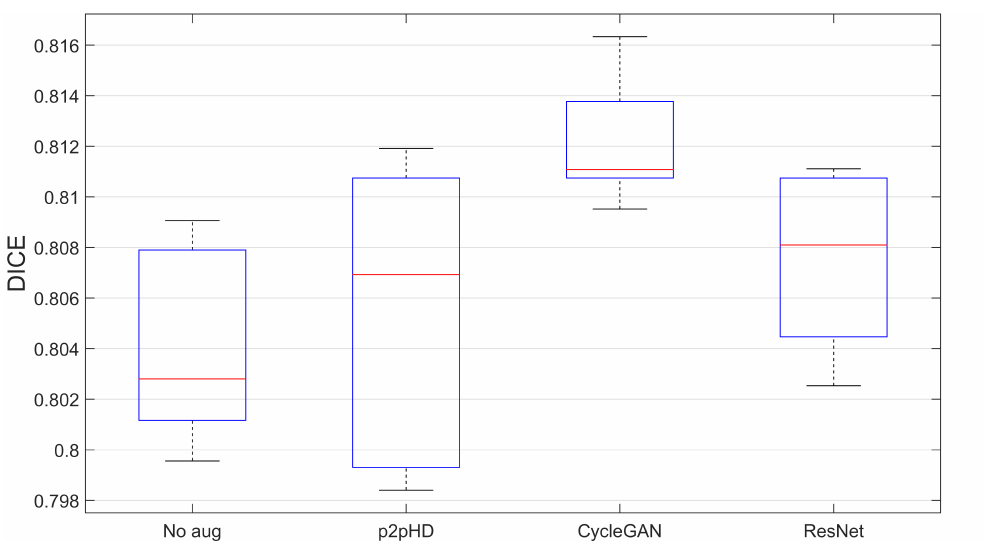
Figure 8. Segmentation model stability results—seed